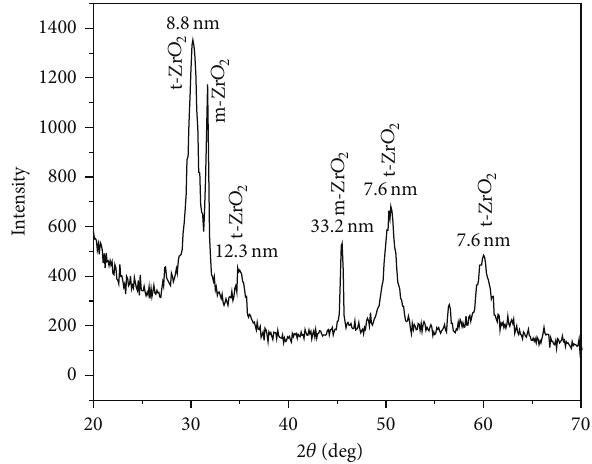
Figure 2: XRD pattern of ZrO 2 NPs calcinated at 400 ∘ C.